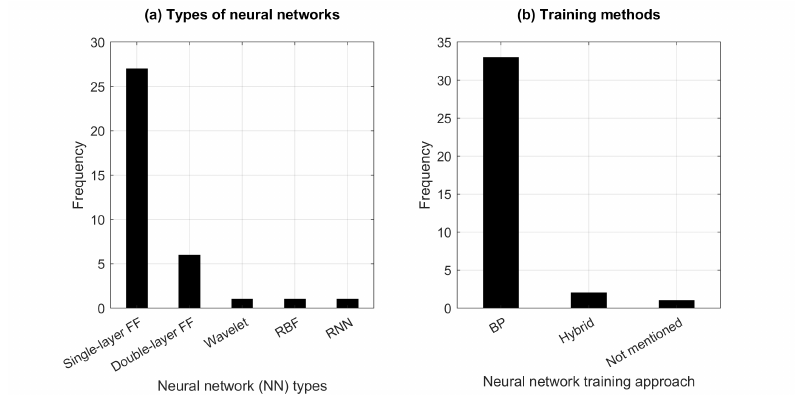
Figure 16. Neural network: ( a ) types of a neural network, ( b ) training methods.